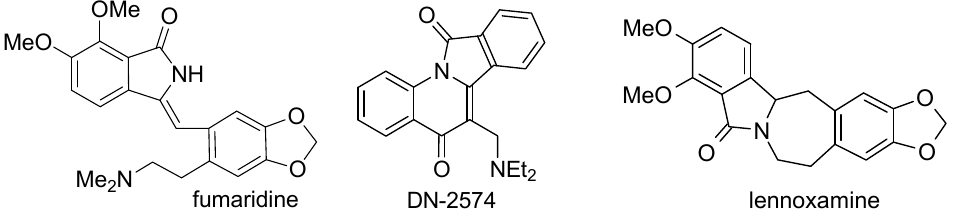
Figure 1. Structures of some natural products and biologically active 3-methyleneisoindolin- 1-one